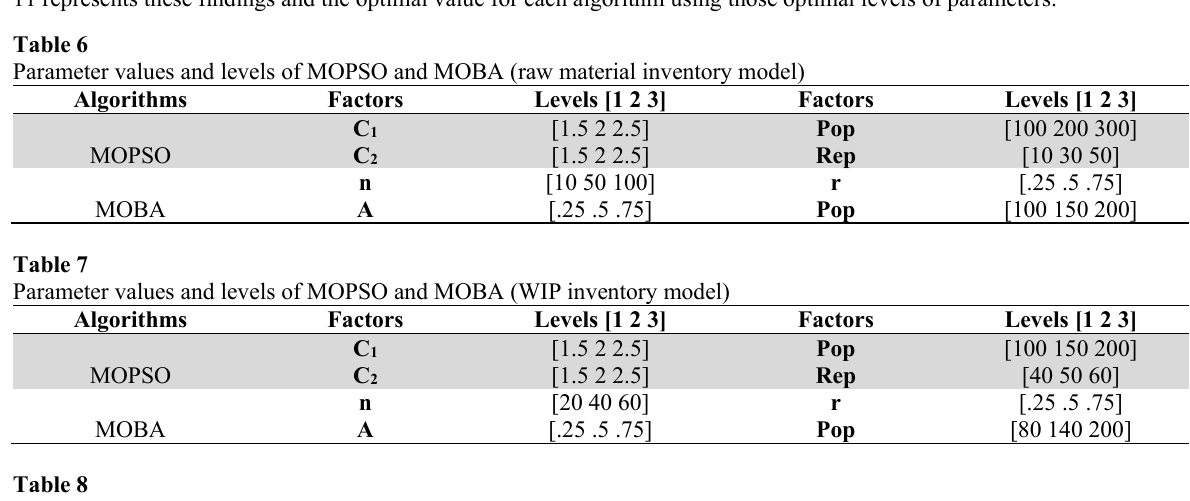
Taguchi L 9 formulation with objective function value (raw material inventory model) Run No.